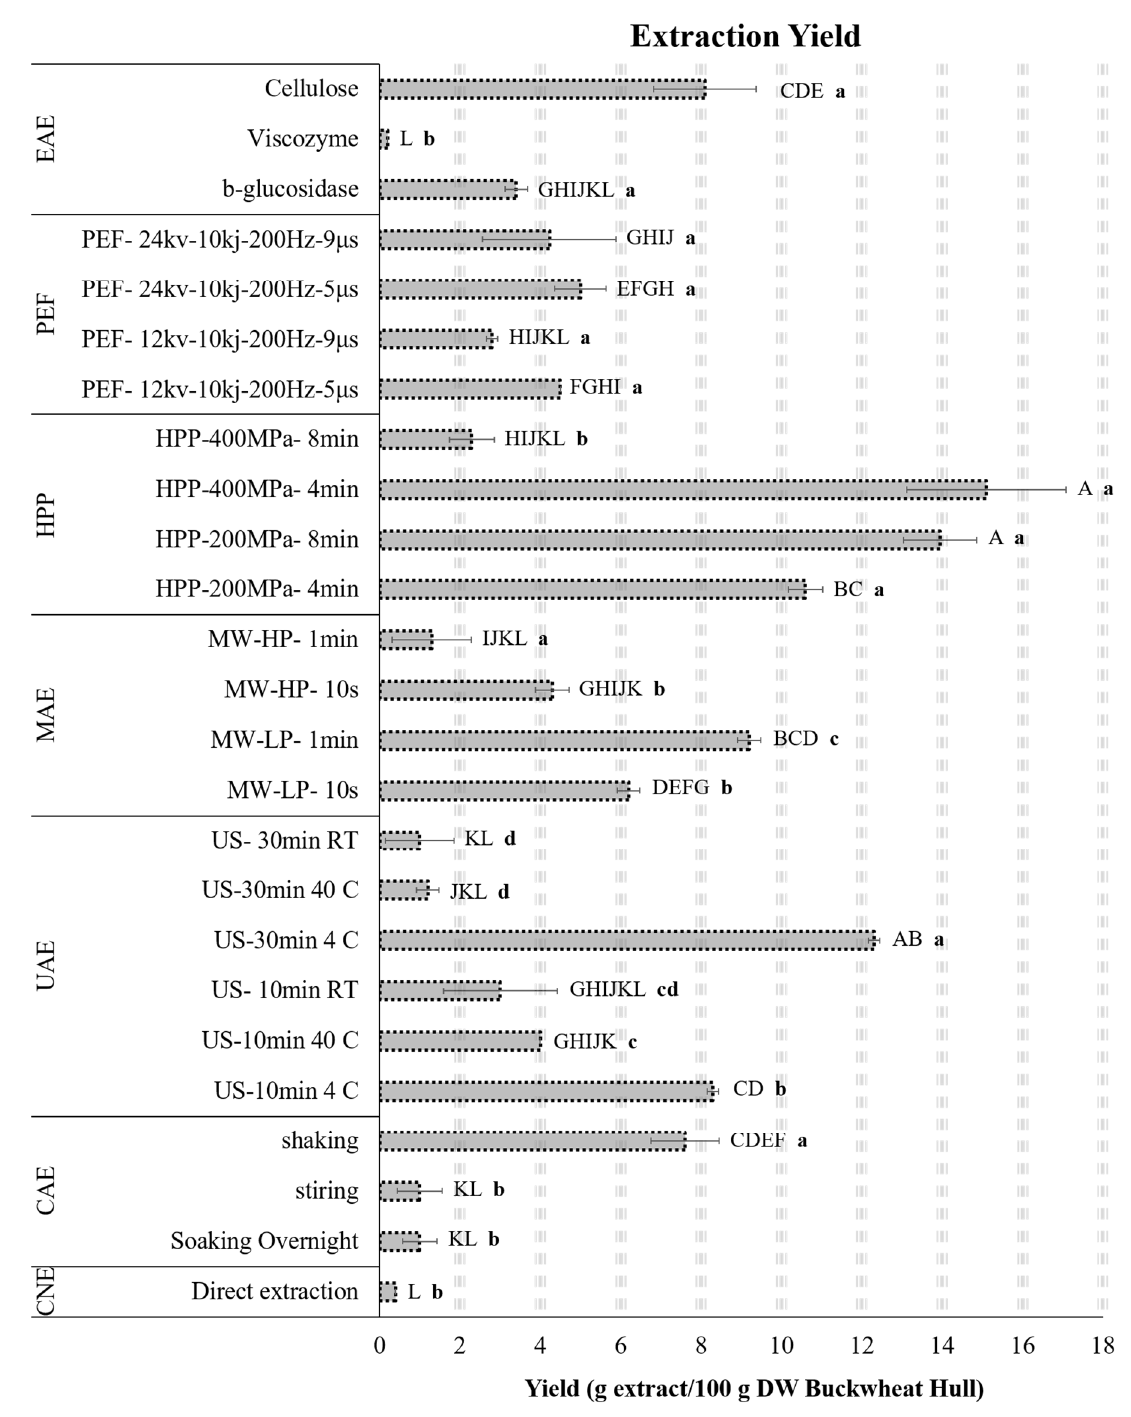
Figure 2. Extraction yields of buckwheat hull extracts using twenty-four extraction strategies, including the control (CNE), conventional-assisted extraction (CAE), ultrasound-assisted extraction (UAE), microwave-assisted extraction (MAE), high-pressure processing (HPP), pulsed electric fields (PEF), and enzyme assisted extraction (EAE) treatments and one control. (Note: results are expressed as the mean ± standard deviation). Extraction yields of extraction strategies that share similar capital letters (A-L) are not significantly different from each other. Whereas small letters (a-d) represent a significant difference between variations in the protocols of each treatment ( p < 0.05).